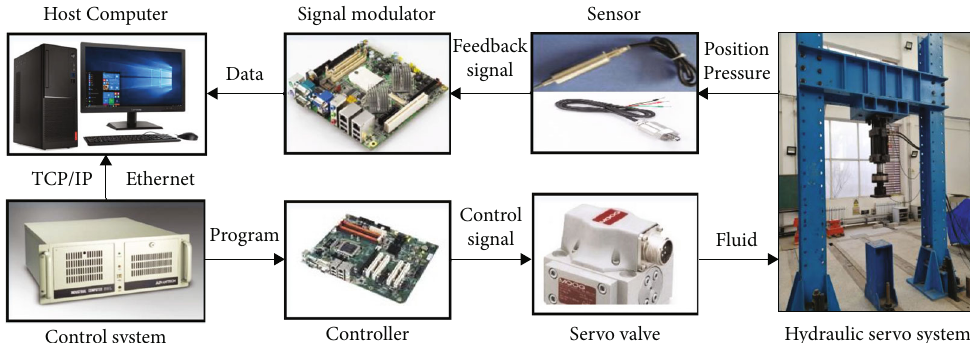
Figure 7: Electro-hydraulic servo system experimental platform.